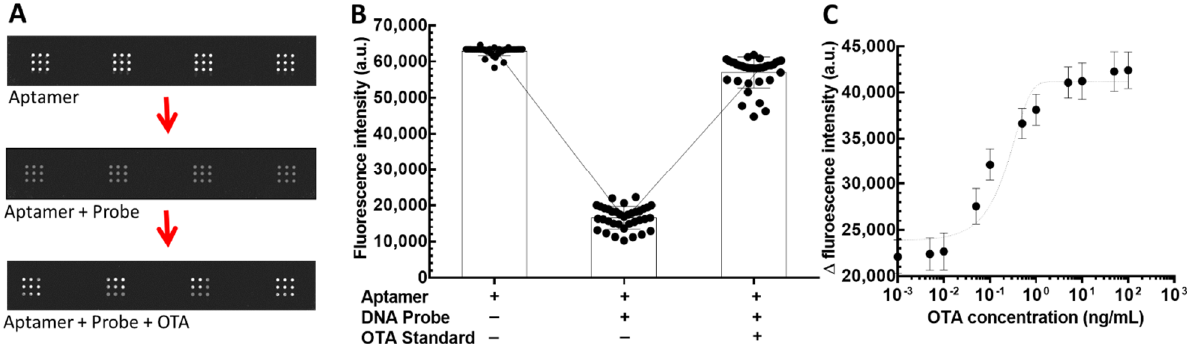
Figure 4. Aptamer-chip-based sample-to-answer biosensor (ACSB) for ochratoxin A (OTA) detection via fluorescence resonance energy transfer (FRET). Signal on–off–on process is shown in ( A ): Cy3-labeled biotinylated aptamer was printed on the streptavidin-coated chip (in 9 × 4 = 36 spot replicates) where the fluorescence signal was on. Upon addition of the quencher BHQ2-labeled DNA probe on the chip, the fluorescence was quenched and the signal was off; however, upon further addition of OTA (the analyte), the OTA–aptamer binding induced the separation between Cy3 and BHQ2, which led to the signal-on again. The fluorescence signals from the above on–off–on process were quantified using Genepix Pro7 ( B ). OTA dose-dependent response curve was established using various concentrations of OTA ( X -axis, log 10 scale) and fluorescence increase ( Y -axis) upon the addition of OTA ( C ).